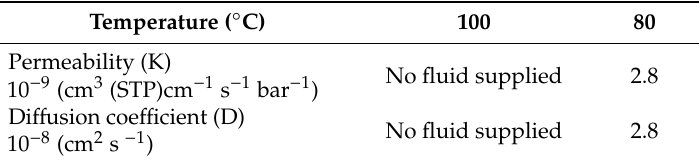
Table 2. Transport coe ffi cients of CO 2 at 150 barg through